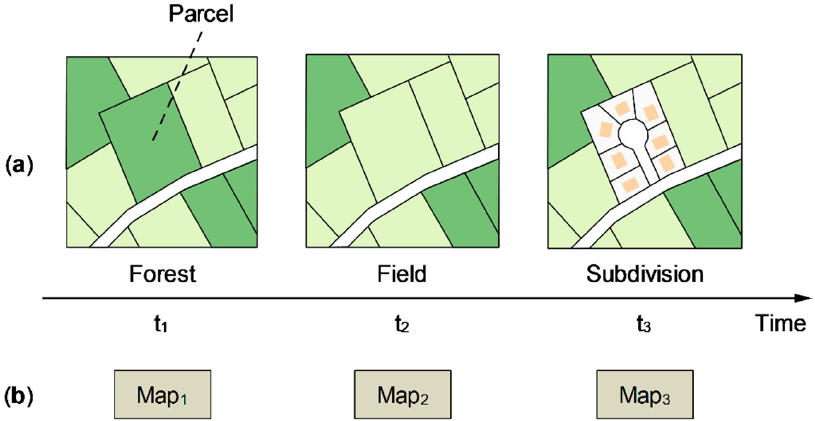
Figure 2. Land evolution illustrated with the sequential snapshots model , ( a ) representation of the real-world entities, ( b ) resulting maps as geographic layers.